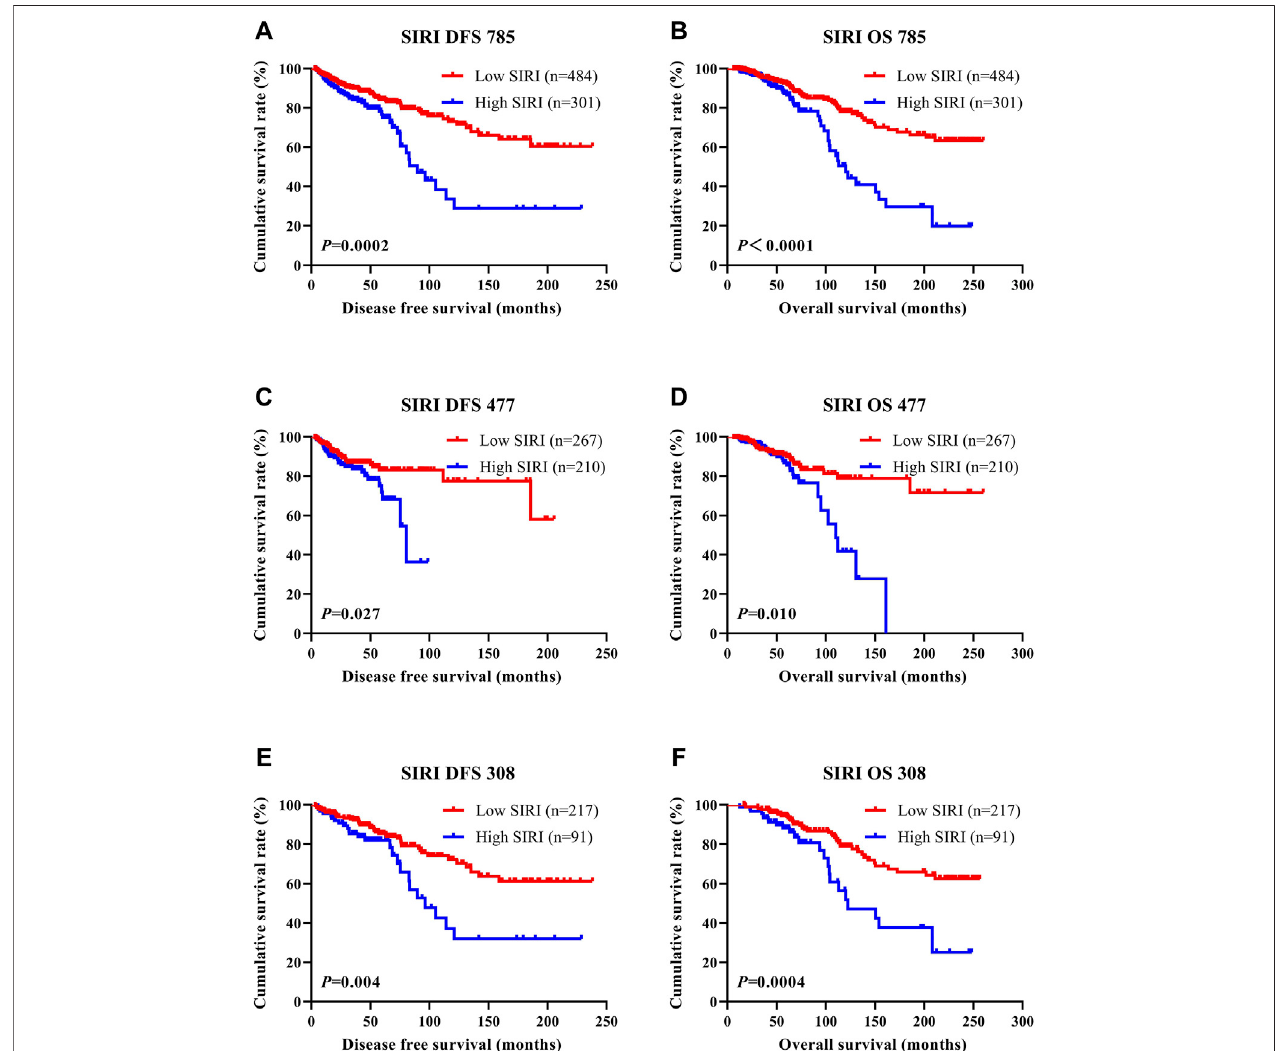
FIGURE 1 | DFS and OS of breast cancer patients. DFS and OS of breast cancer patients. (A) Kaplan-Meier analysis of DFS for the SIRI of all patients with breast cancer. (B) Kaplan-Meier analysis ofOSfortheSIRIofallpatientswithbreast cancer. (C) Kaplan-MeieranalysisofDFS for theSIRI ofpatientswithbreast cancer (NACT group). (D) Kaplan-Meier analysis of OS for the SIRI of patients with breast cancer (NACT group). (E) Kaplan-Meier analysis of DFS for the SIRI of patients with breast cancer (non-NACT group). (F) Kaplan-Meier analysis of OS for the SIRI of patients with breast cancer (non-NACT